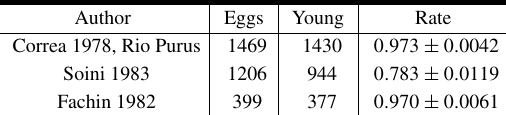
Podocnemis unifilis , hatching